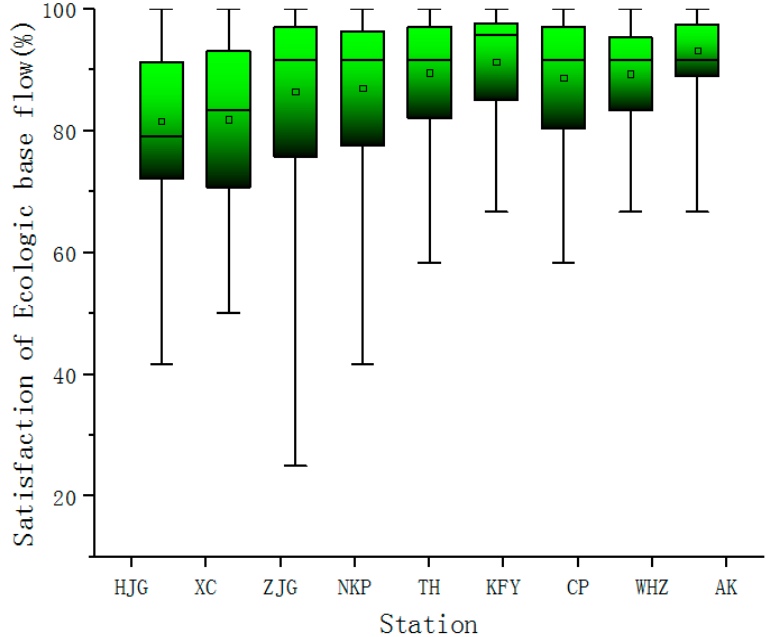
Figure 6. Distribution of ecological satisfaction degrees by the minimum monthly average flow with 90% guarantee rate method (Mm9M) method in the Han River basin.